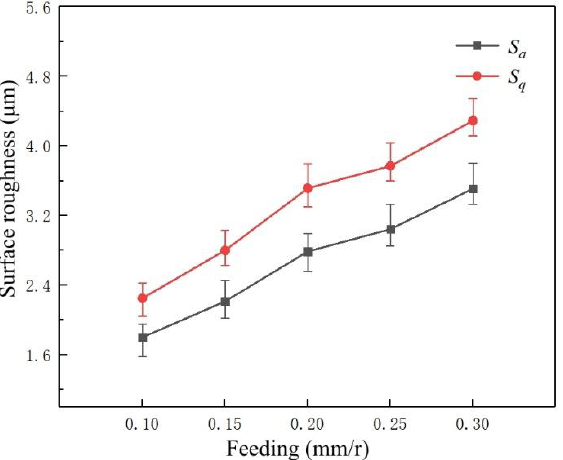
Figure 7. The variation trend of feed rate on the roughness of the machined surfaces.